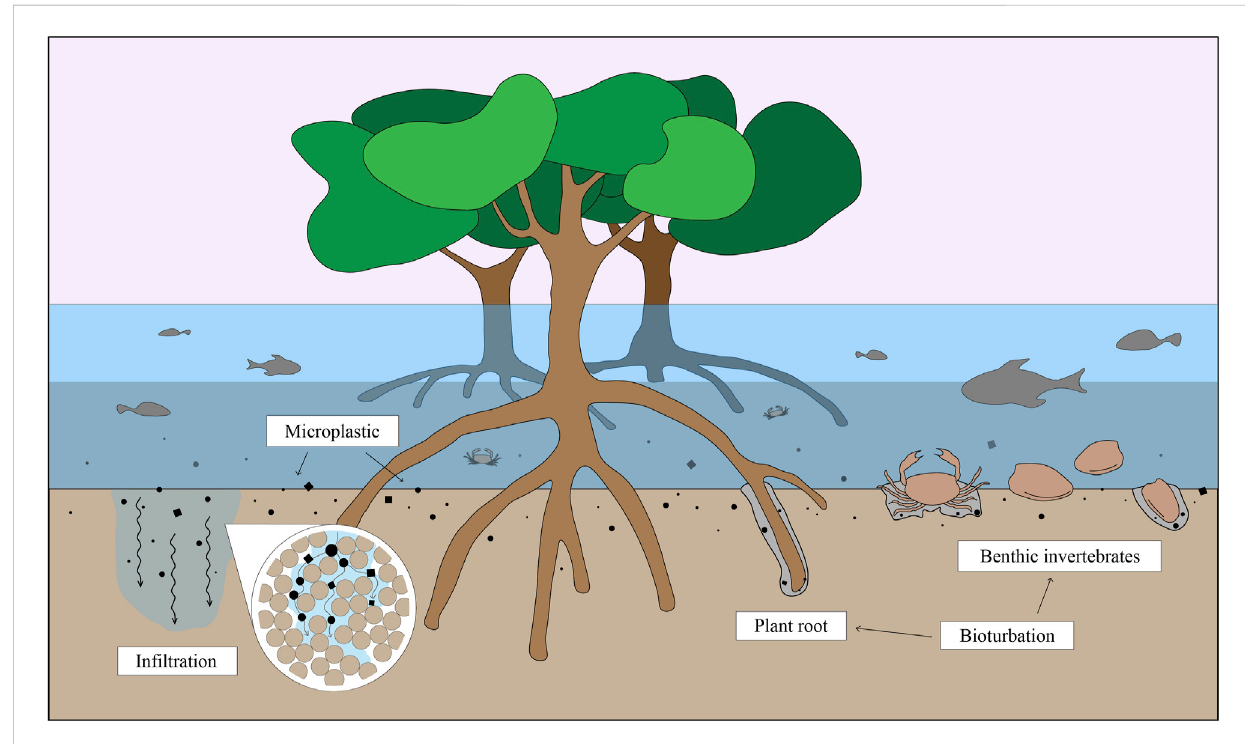
FIGURE 9 Graphic showing how bioturbation transports microplastics deep into the mangrove